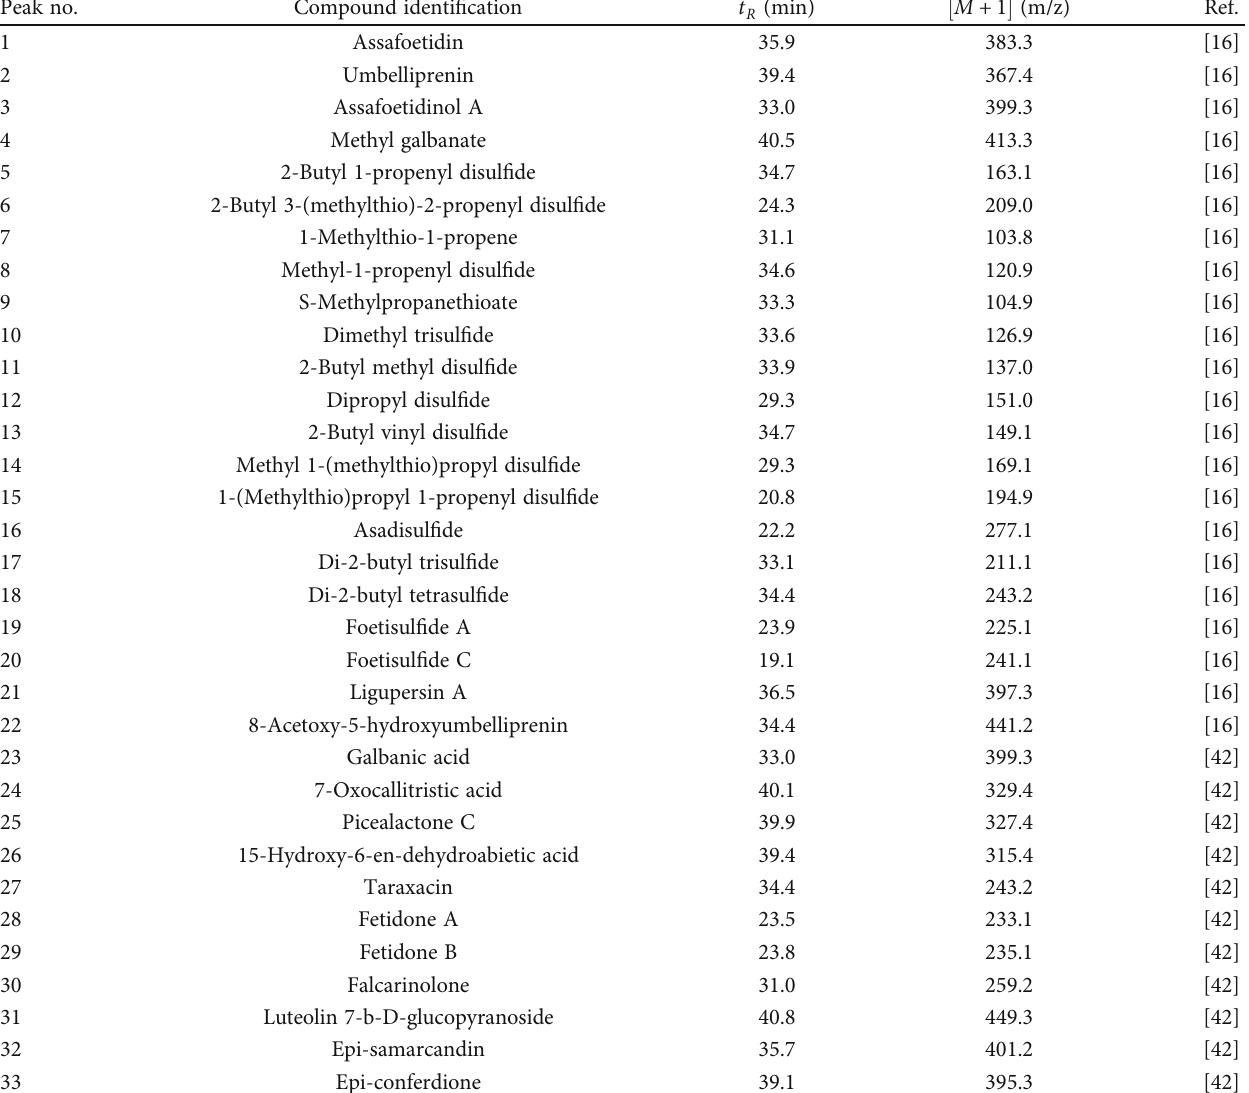
Table 2: Peak assignment of metabolites in the hydroethanol extract of Ferula assafoetida using LC-MS in the positive mode. Peak